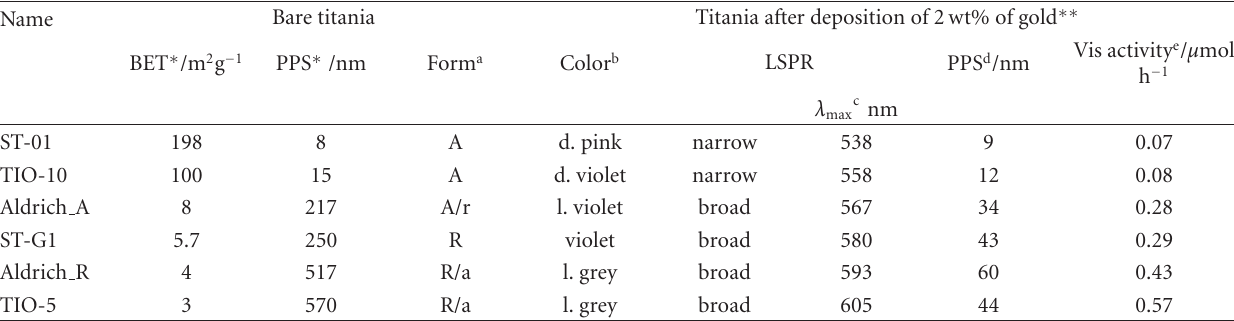
Table 1: Properties of bare and gold modified TiO 2